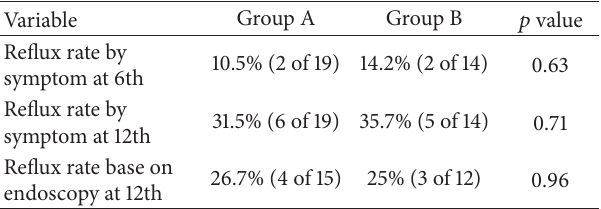
Table 6: Comparison of reflux